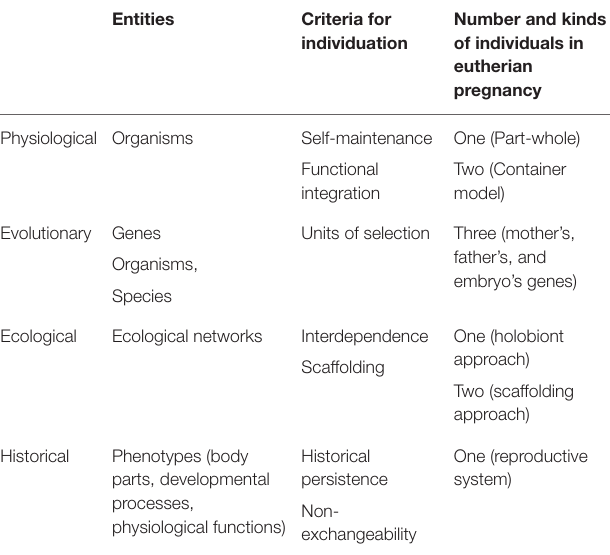
TABLE 1 | Comparative table of concepts of biological individuality and how they apply to pregnancy.